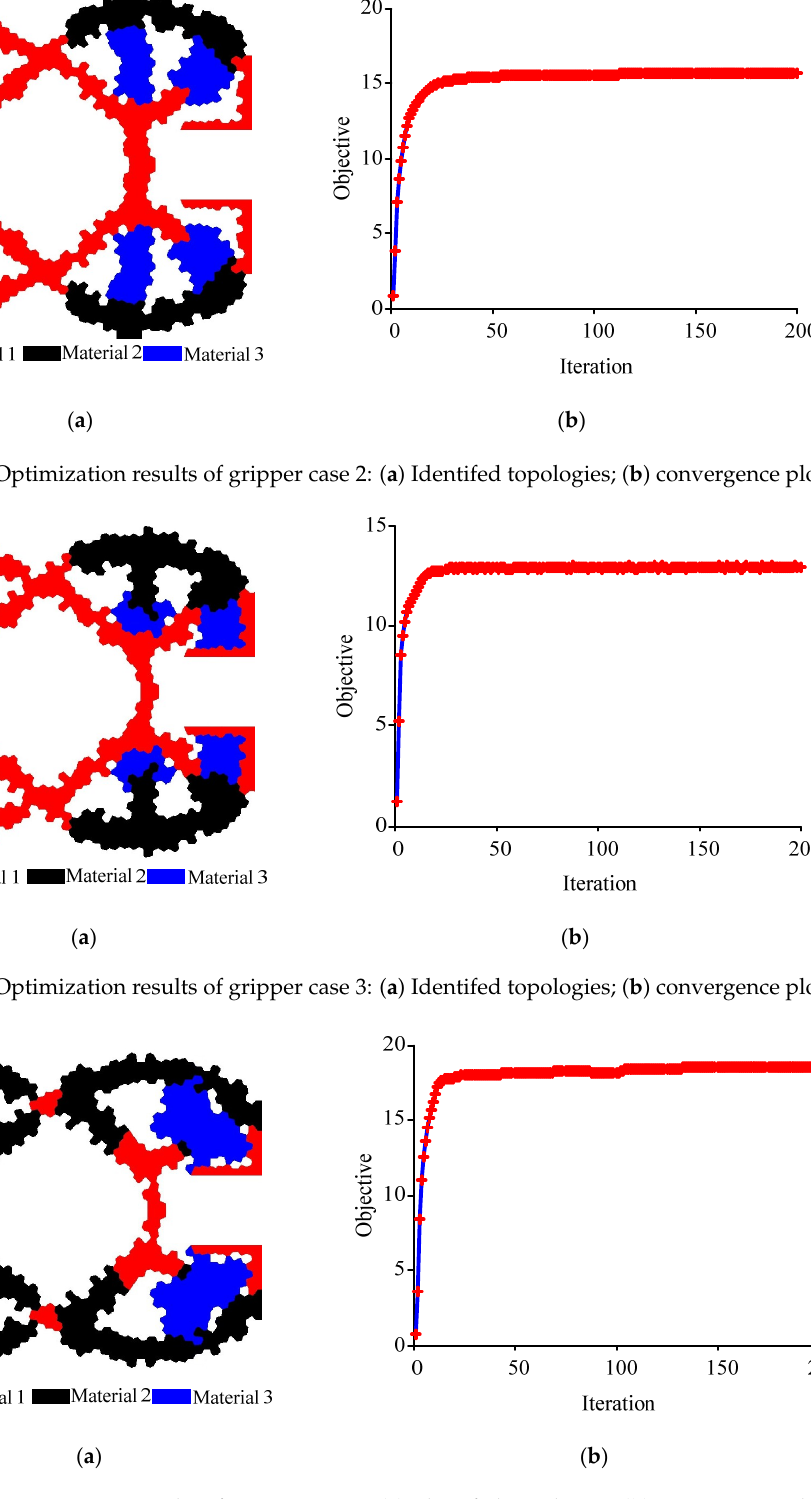
Figure 13. Optimization results of gripper case 4: ( a ) Identifed topologies; ( b ) convergence plot.